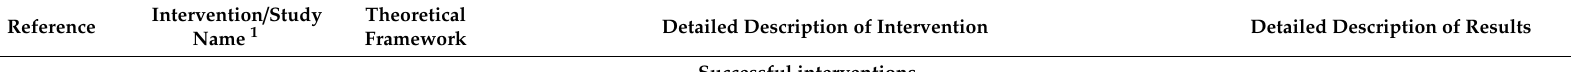
Table 2. Detailed descriptions of the school-based interventions among preschoolers (ages 2–5) in low socioeconomic